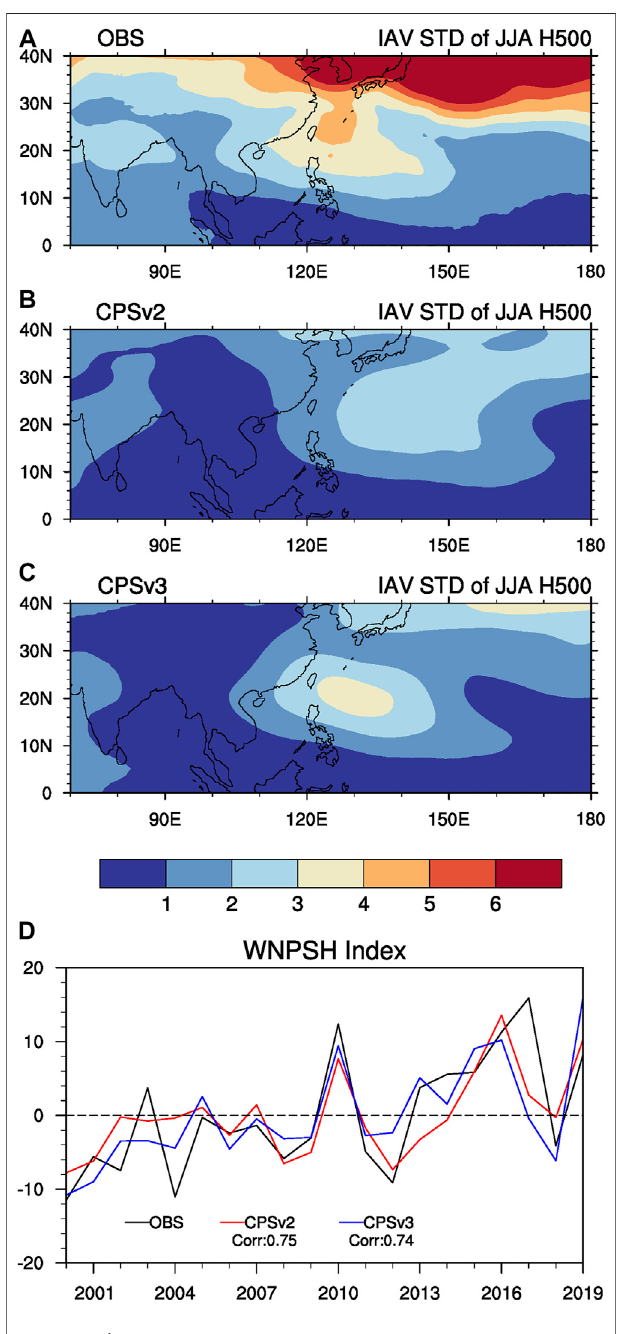
Frontiers in Earth Science |